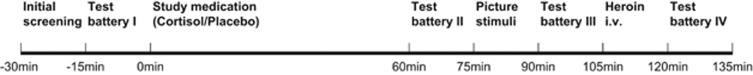
Course of the study. The x axis illustrates the time line. Study medication (that is, cortisol or placebo) is administered at 0 min.